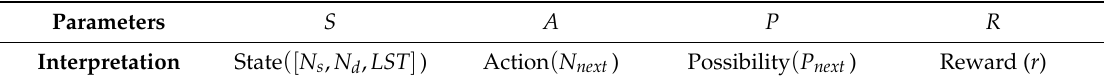
Figure 3. Virtual Node (VN)-based satellite networks topology. Table 3. Agent model of reinforcement